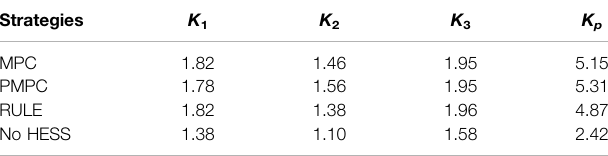
TABLE 3 | AGC performance within 1 day under different strategies. Strategies